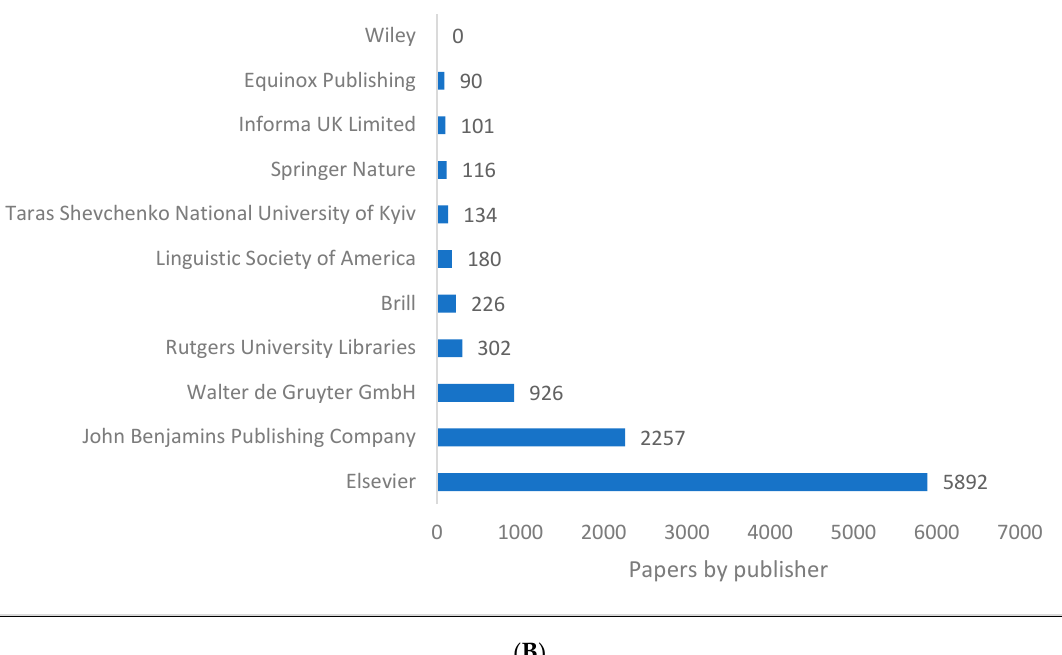
Figure 5. Pragmatics knowledge production size by publisher. ( A ) (WOS). ( B ) (Lens).